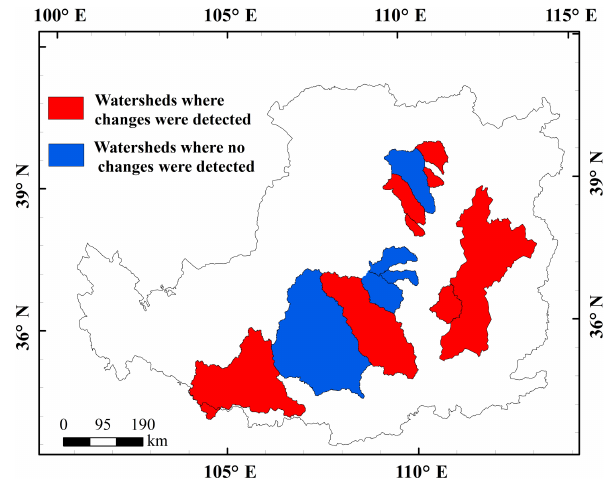
Figure 6. Spatial distribution of watersheds with and without sig- nificant changes in the PRR during the drought